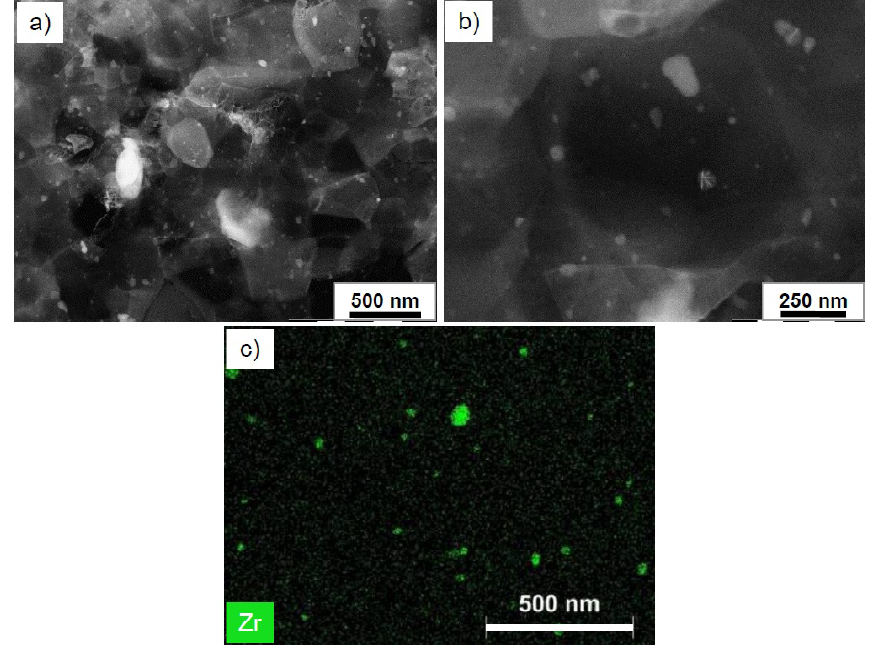
Fig. 2. Microstructure of Al–0.4Zr(wt.%) alloy after AG–HPT treatment: (a,b) – bright field and dark field TEM images of nanoscale Al Zr precipitates, (c) – EDX map of 3